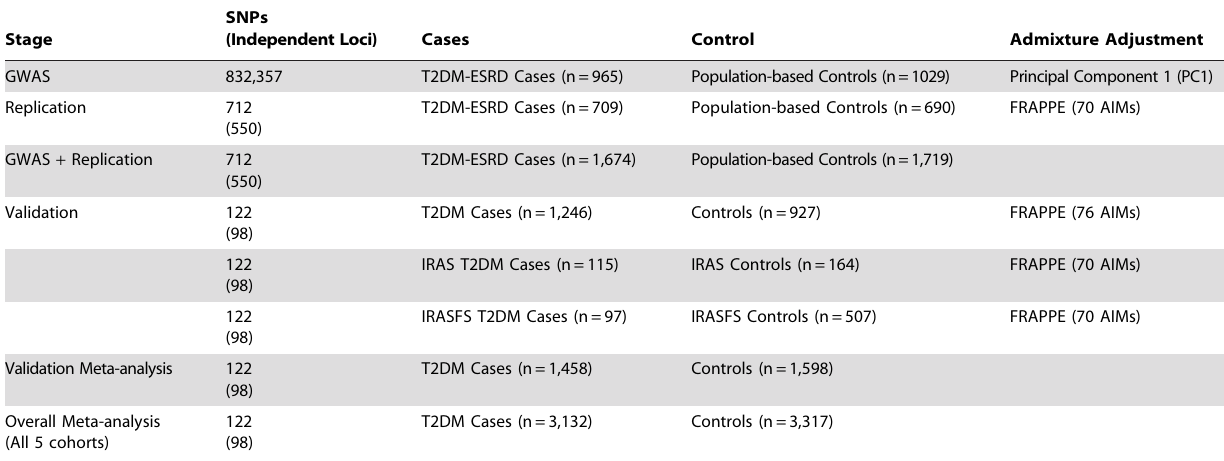
Table 2. Study Design.